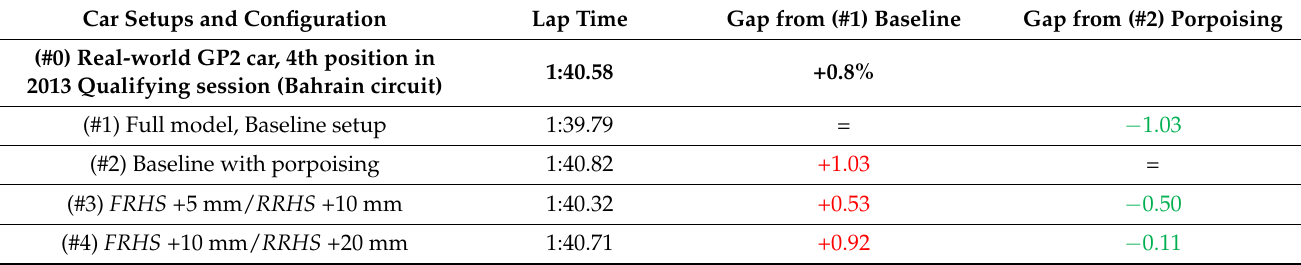
Table 1. Configurations tested with related lap time. Faster lap time gaps in green, slower in red.